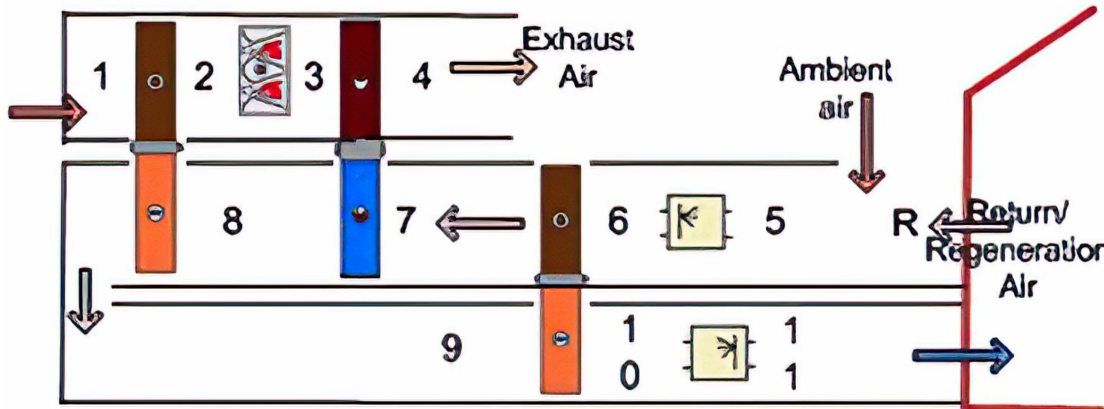
Figure 6. Schematic of ventilated-dunkle cycle